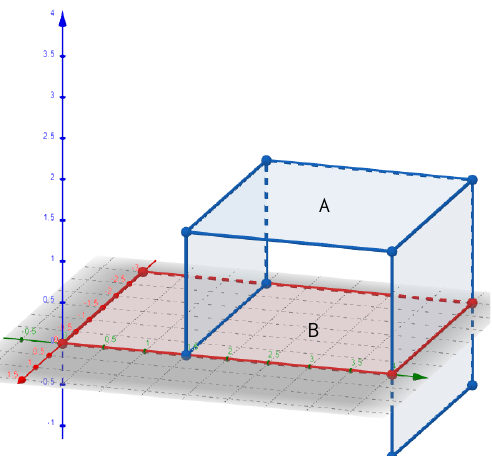
Figure 7 . 2D to 2D “meet (touches)” topological relationship at an